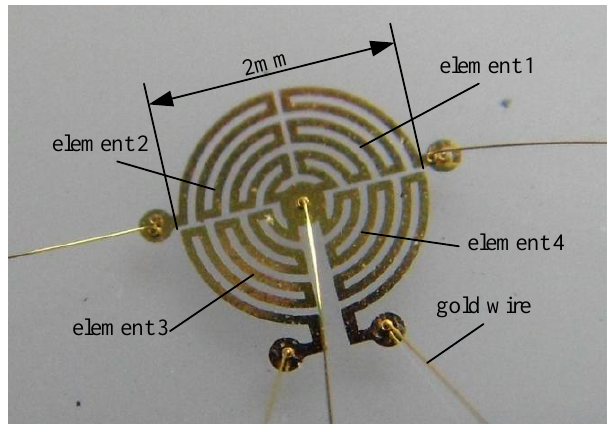
Figure 1. Prototype of hot-film flow vector